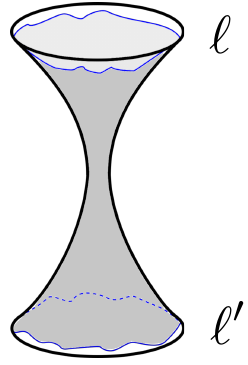
Figure 3 . The basic observable of de Sitter JT gravity is the annulus partition function, Z 0 , 1 , 1 ( ‘, ‘ 0 ) , the path integral over global nearly dS 2 space and metric/dilaton configurations connected to it. Properly normalized it gives the leading expression for the infinite-time evolution operator in